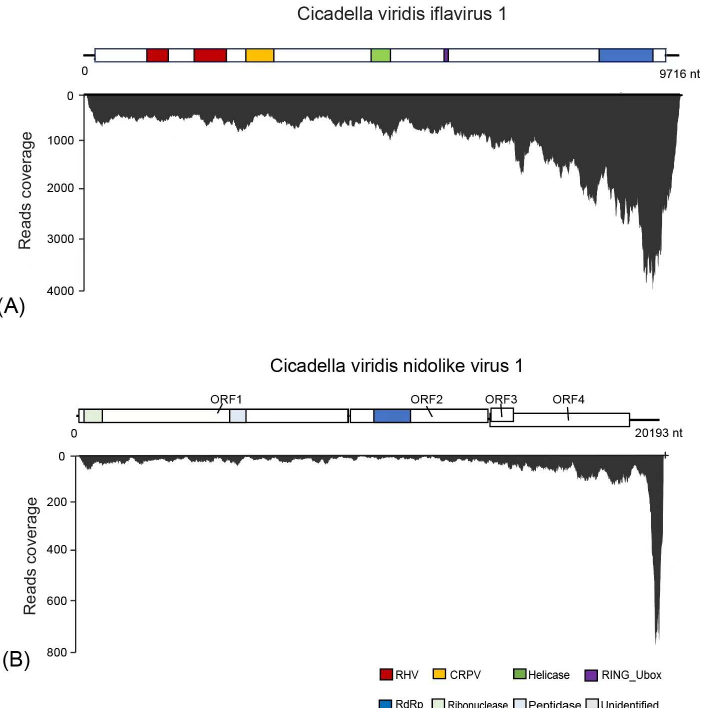
Figure 1. Genomic structure and RNA-seq read coverage of Cicadella viridis iflavirus 1 ( A ) and Cicadella viridis nido-like virus 1 ( B ). The boxes represent the open reading frames (ORFs) of each virus. Conserved functional domains are color-coded and their corresponding names are indicated at the bottom of the figure. Abbreviation of the conserved domain names: RHV , picornavirus capsid protein domains; CRPV , cricket paralysis virus capsid superfamily domain; RdRp , RNA-dependent RNA polymerase domain.